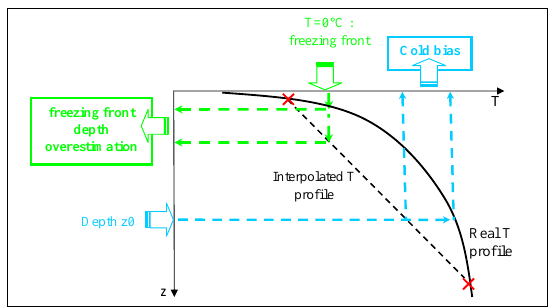
Fig. 3. Consequences of the linear interpolation (black, dash) of a temperature profile (black) in-between vertical nodes. The linear interpolation of a winter profile leads to a systematic overestima- tion of the freezing front depth, or equivalently, a cold bias between thermal